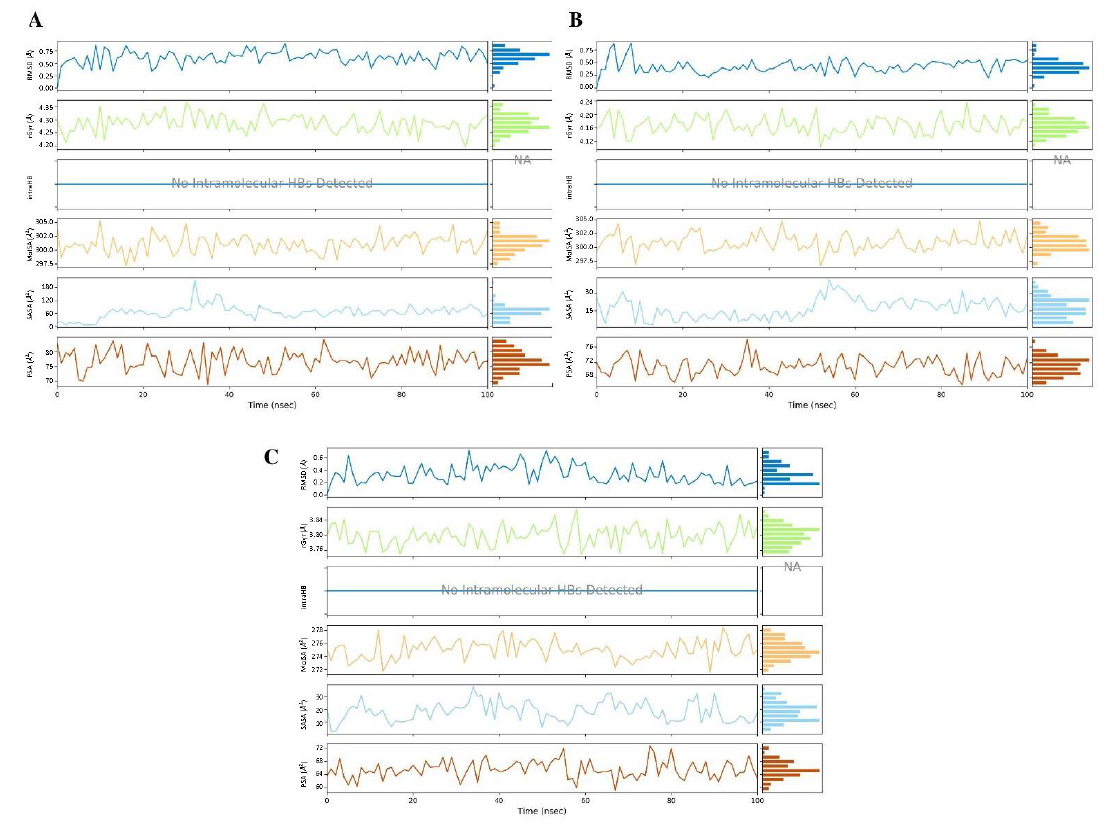
Figure 8. Various measures of the molecular dynamics simulations of three compounds, ( A ) ( 50 ), ( B ) ( 52 ) and ( C ) ( 54 ), within the pockets of human placental aromatase cytochrome P450 target.